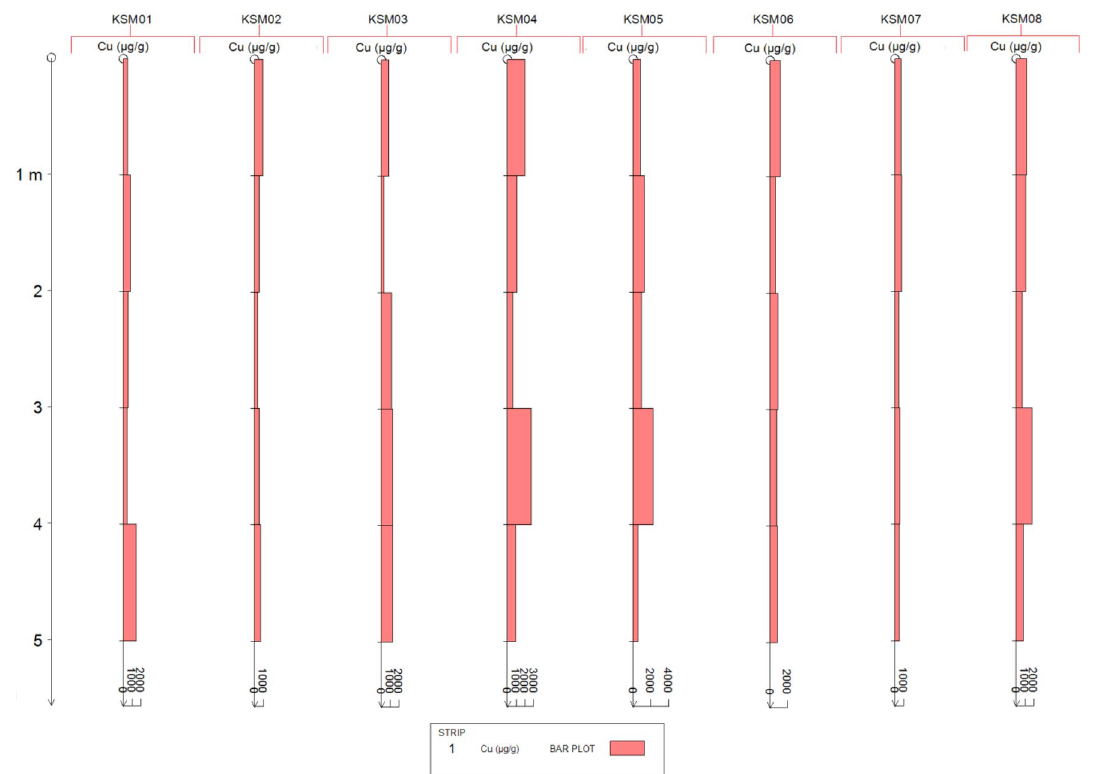
Fig. 3 Strip log showing Cu metal concentration and distribution in